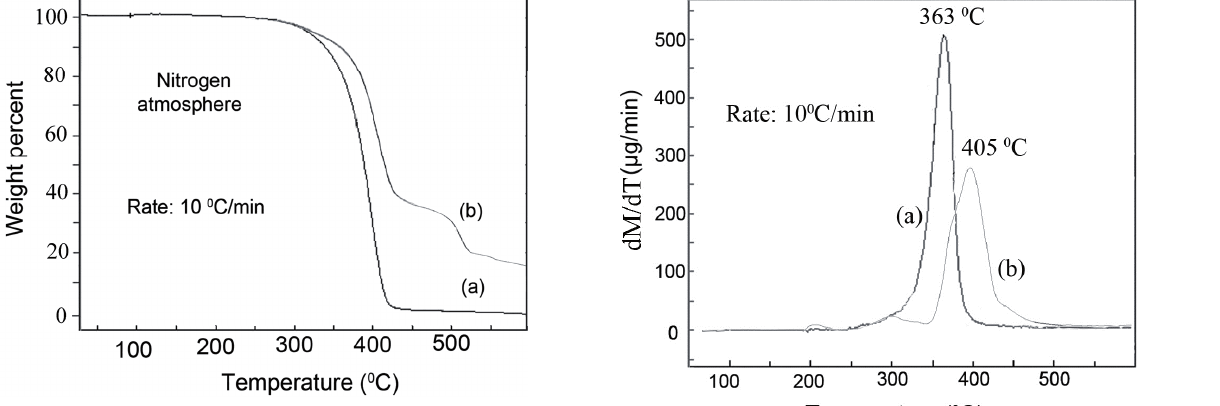
Figure 14. TGA curves of (a) PS, (b) PS/Sb 2 O 3 -Br com- pound.